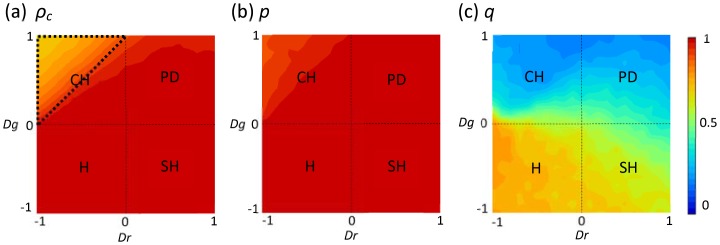
Color map depicting (a) fraction of cooperation , (b) p, and (c) q on the Dg-Dr parameter plane.Obviously, in the top left corner of CH where Dg>Dr+1 (or 2R<S+T) is satisfied (surrounded by black dotted line), incomplete cooperation is emerged (namely, the so-called ST-reciprocity [46]), which can lead to high payoff than the case of complete cooperation (the so-called R-reciprocity [47]).